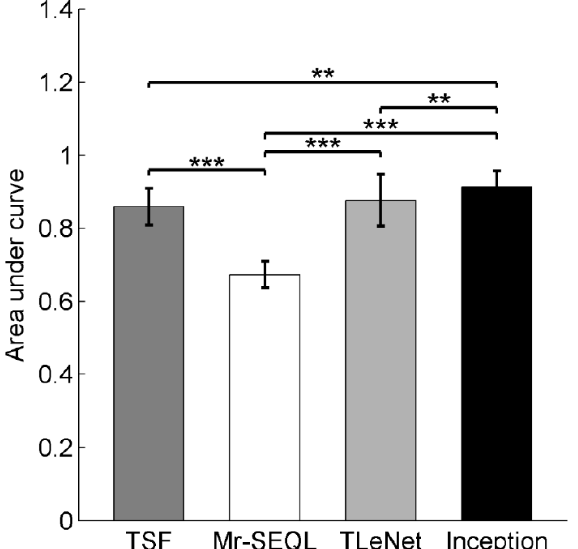
Figure 3. Post-hoc comparison of the area under curve (AUC) across the TSF, Mr-SEQL, TLeNet, and Inception models. The Inception model had a significantly larger AUC value than the other three models, and the Mr-SEQL model had a significantly smaller AUC value than other models. ** indicates <0.01, *** indicates <0.001.